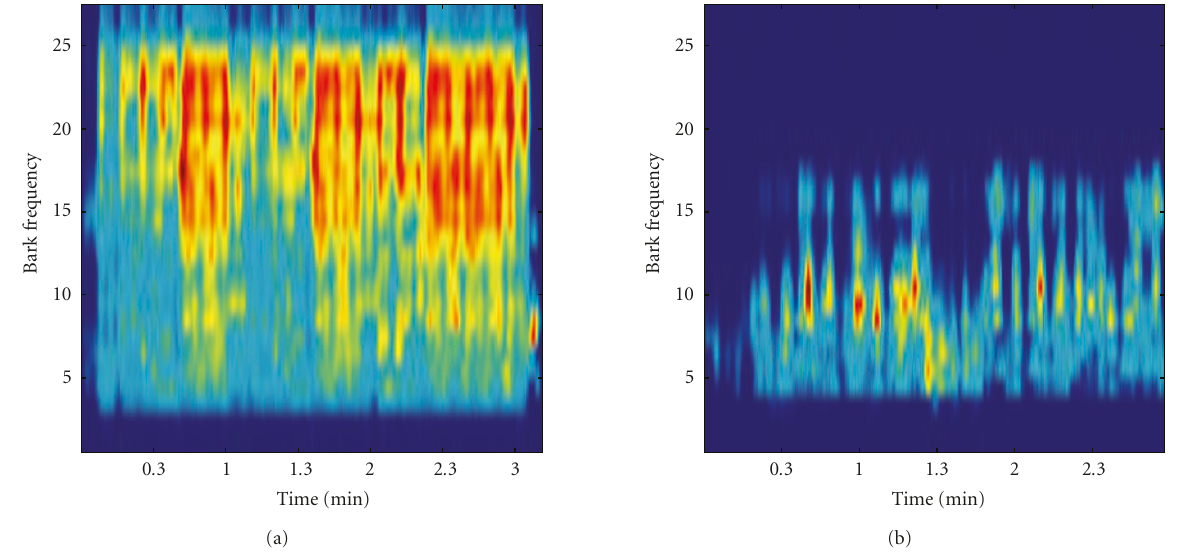
Figure 2: Timbregram: PLP calculated using the GWS of (a) Whenever, Wherever and (b) All of Me